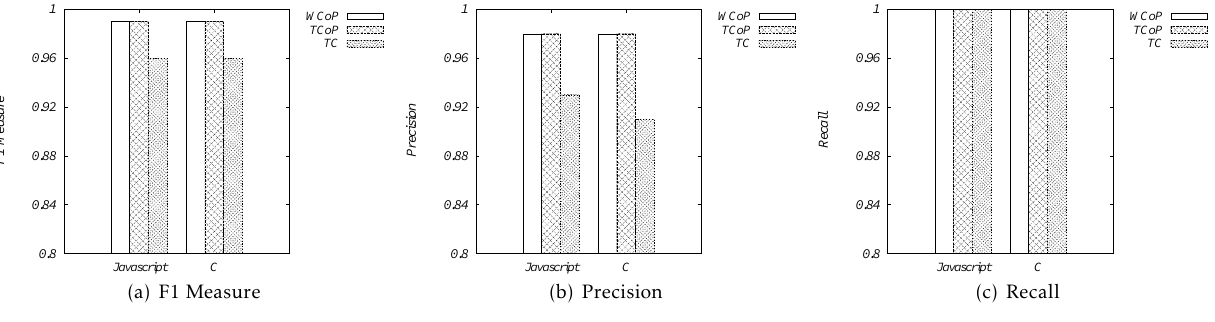
Figure 9. F1, Precision and Recall of WCoP, TCoP and Text Classification on sample pages of “Programming Languages" domain